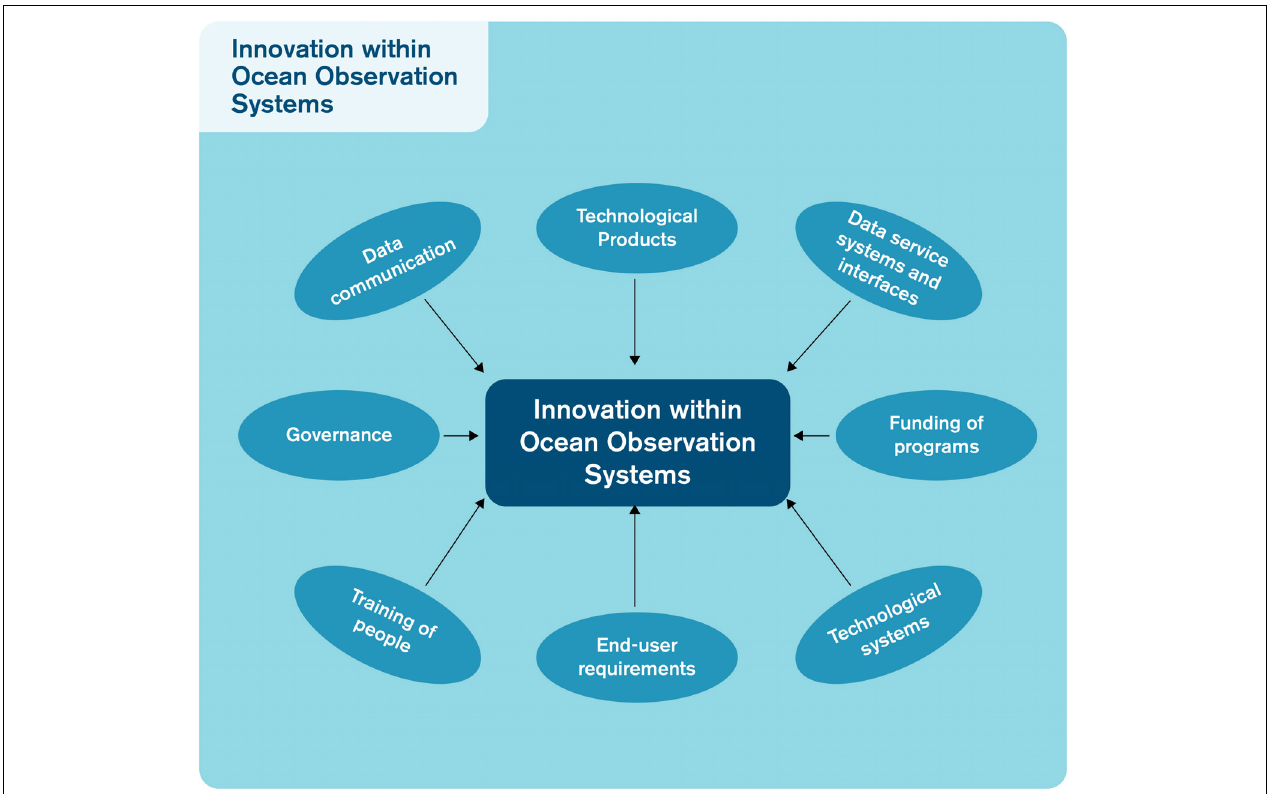
FIGURE 9 | Innovation within ocean observation systems. Innovation in ocean observing can take many forms. For sustainable ocean observing, all forms of innovating, including reviewing and updating, will need to be integrated into